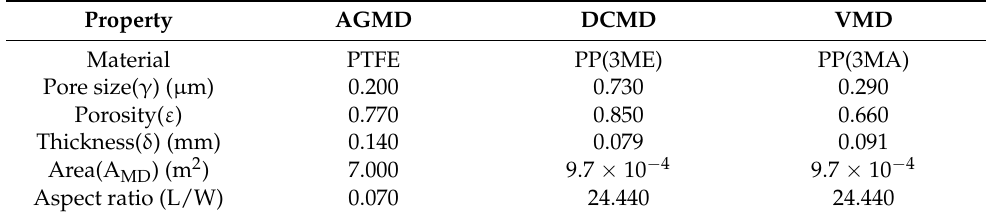
Table 2. Membrane information [30–32].